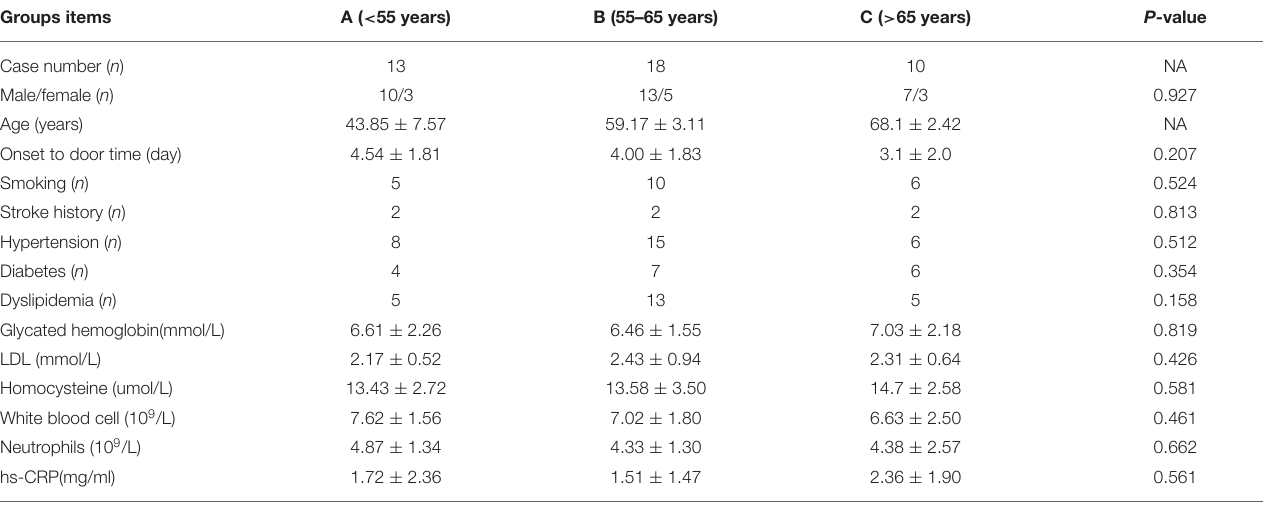
TABLE 1 | Demographic data of all patients.